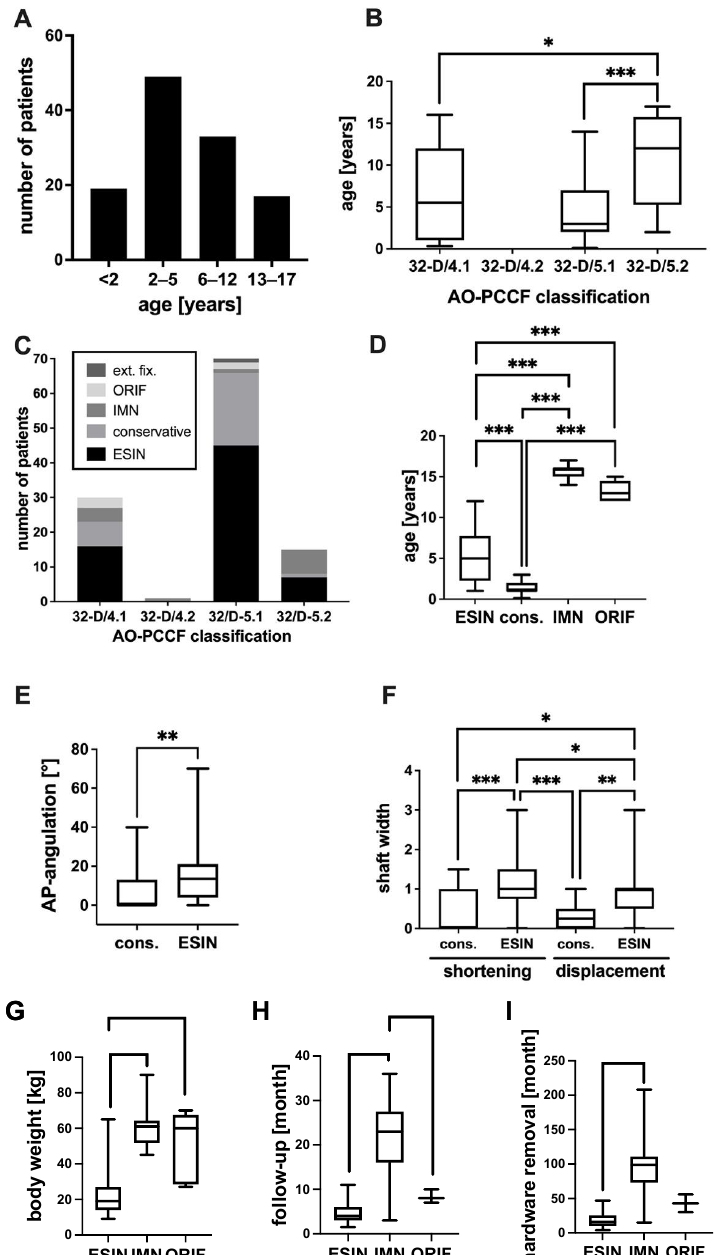
Figure 1. ( A ) Number of patients in the respective age groups of <2, 2–5, 6–12 and 13–17 years. ( B ) Patient age for the different fracture types: 32-D/4.1, 32-D/4.2, 32-D/5.1 and 32-D/5.2, according to the AO Pediatric Comprehensive Classification of Long Bone Fractures (AO-PCCF). ( C ) Numbers of patients and treatment strategies in the different AO-PCCF-fracture types: 32-D/4.1, 32-D/4.2, 32-D/5.1 and 32-D/5.2. ( D ) Angulation in the anterio-posterior X-ray projection in conservative- treated and ESIN-treated patients. ( D ) Patient age in the different treatment groups of flexible intramedullary nailing (ESIN), conservative (cons.), intramedullary nailing (IMN) and open reduc- tion and internal fixation (ORIF) with plate osteosynthesis. ( E ) AP-Angulation in patients treated conservatively or with ESIN. ( F ) Shortening and fracture displacement in conservative-treated and ESIN-treated patients, depicted in the shaft width. ( G ) Weight of patients in respective treatment groups. ( H ) Duration of follow-up in months in the respective treatment groups. ( I ) Duration to hardware removal in months. Differences between groups were significant, as indicated: *: p < 0.05, **: p < 0.01, ***: p <